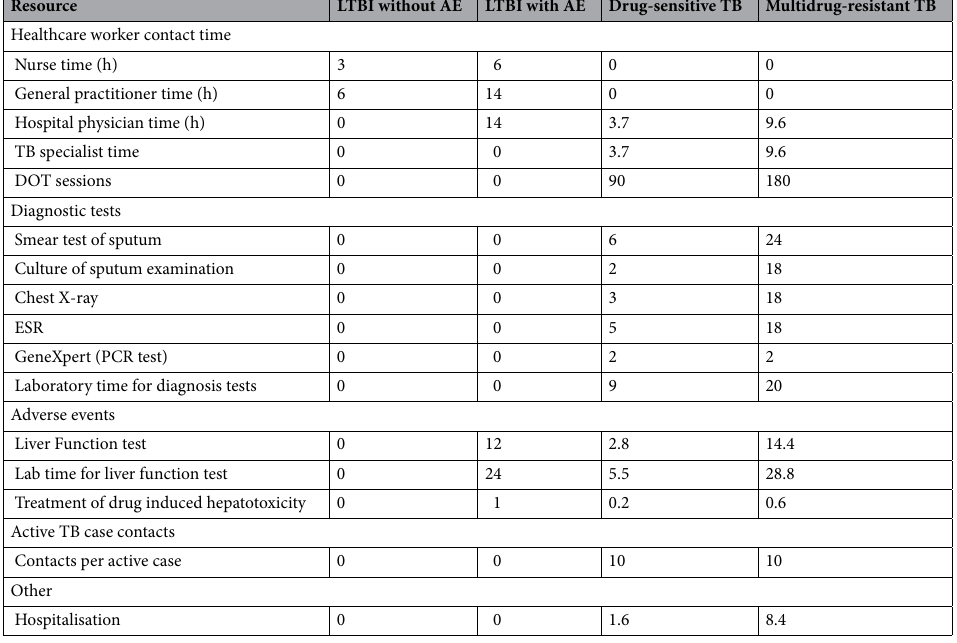
Table 3. Resource use. All resource use were sourced by QIAGEN from national sources for Malaysia. The resource values in the PSA were assumed to have a standard error of 10% and a Gamma distribution was used. AE Adverse event, DOT Directly observed therapy, ESR Erythrocyte sedimentation rate, LTBI Latent tuberculosis infection, PCR Polymerase chain reaction, PSA Probabilistic sensitivity analysis, TB